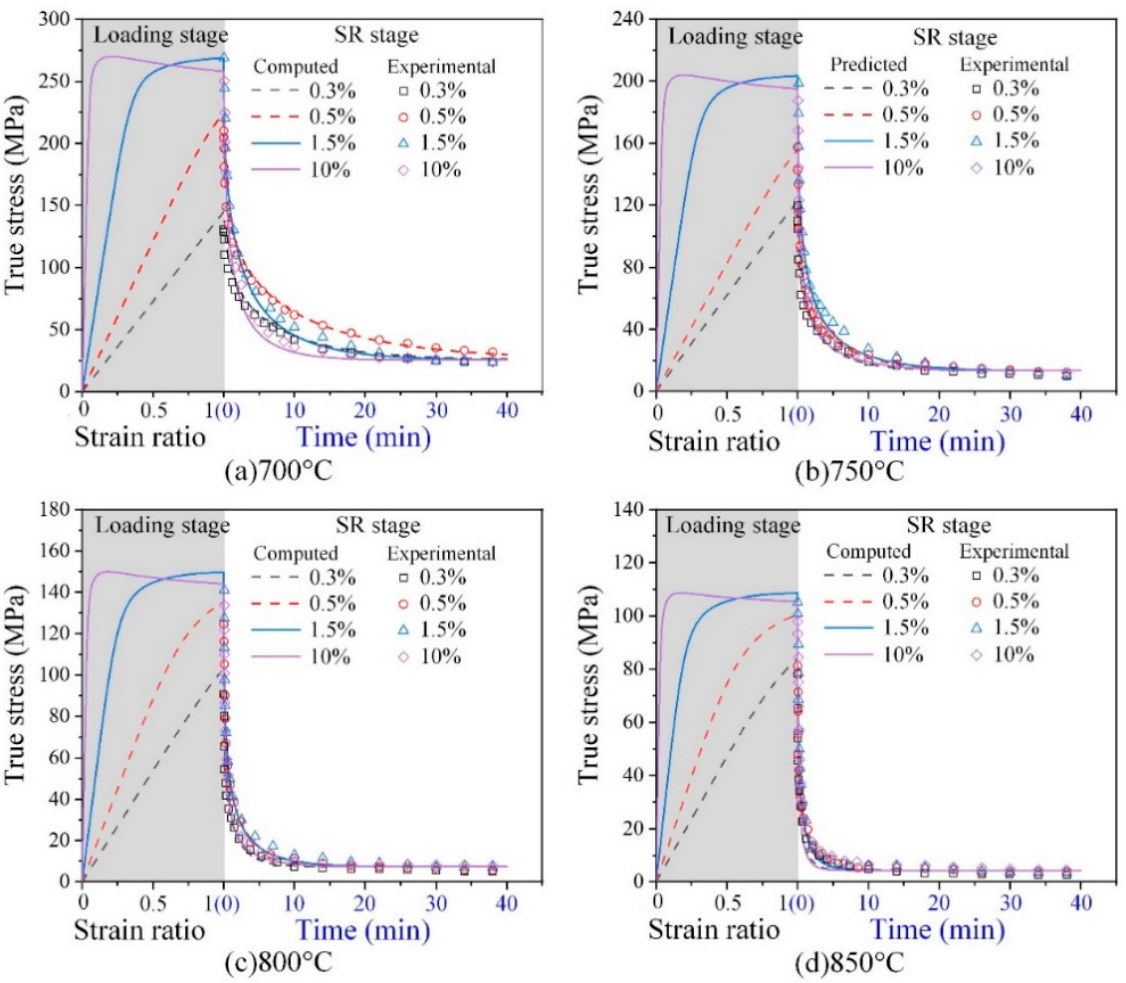
Figure 10. Comparison of whole stress relaxation curves of simulation (solid line) and experiment (symbol) with different pre-strain and temperature, in which ( a ) 700 ◦ C, ( c ) 800 ◦ C and ( d ) 850 ◦ C are the fitting data and ( b ) 750 ◦ C is the verification data.